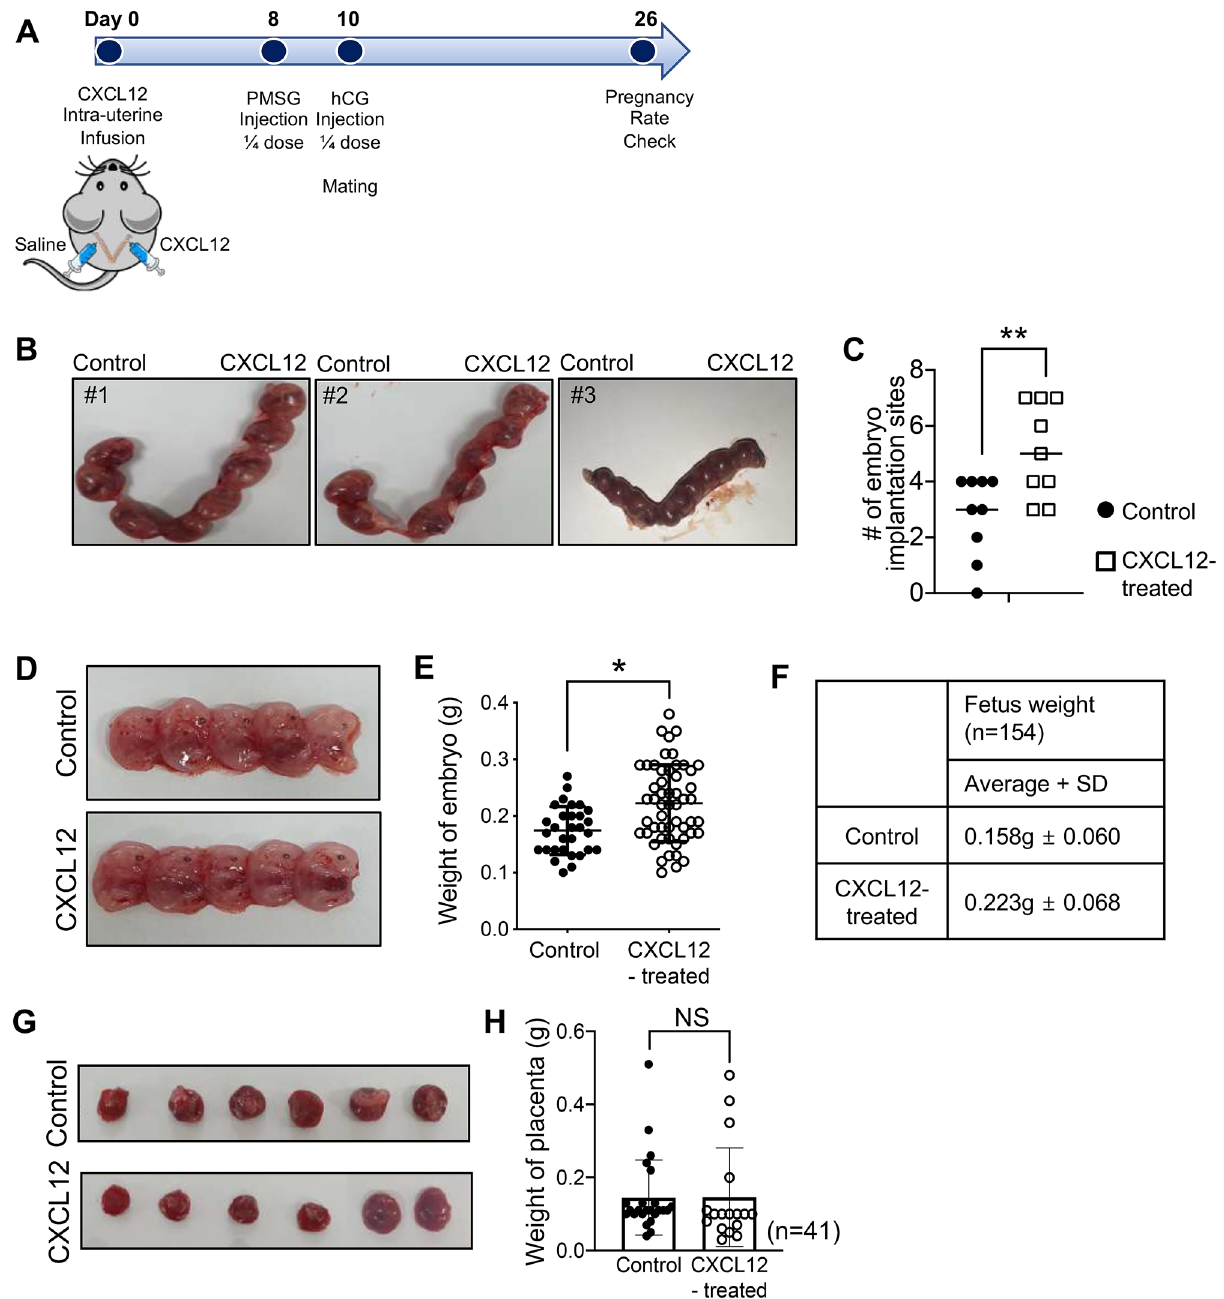
Figure 6. Impact of minimally-invasive intra-uterine CXCL12 treatment on the pregnancy rates. ( A ) A schematic diagram of an experimental plan for the fertility assessment followed by intra-uterine CXCL12 infusion. ( B ) Representative images of CXCL12-treated uteruses including sites of embryo implantation compared to saline-treated controls. Average numbers of embryo implantation sites were quantified in the graph shown in ( C ). ( D ) Representative images of embryos obtained from CXCL12-treated or saline-treated mouse uterus. ( E , F ) Average weight of embryos obtained from CXCL12-treated uterus compared to control. ( G ) Representative images of placenta derived from Control versus CXCL12-treated mouse uterus. Average weight of placenta obtained from CXCL12-treated uterus compared to control are shown in graph ( H ). Data shown for ( B-H ) are from 3 independent experiments (# of mice; 34, # of embryos; 162), and analyzed using paired t test analysis including p-values. (*< 0.05, **< 0.01, NS; not